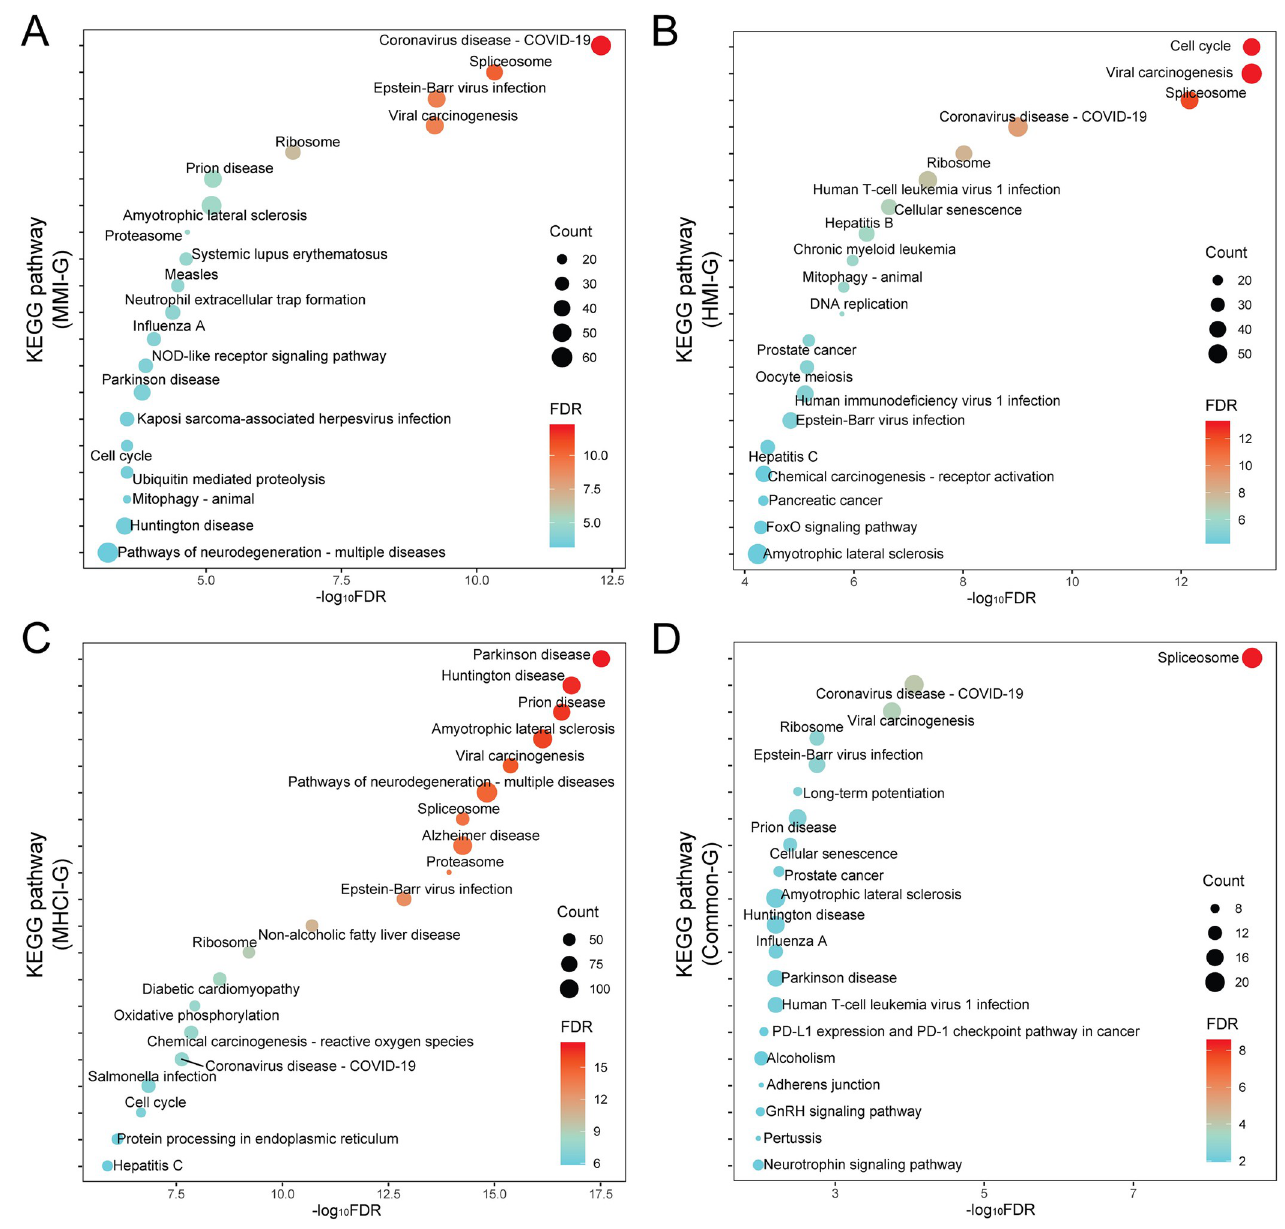
Fig 7. KEGG pathway analysis of disease-related genes. (A) MMI-G. (B) HMI-G. (C) MHCI-G. (D)